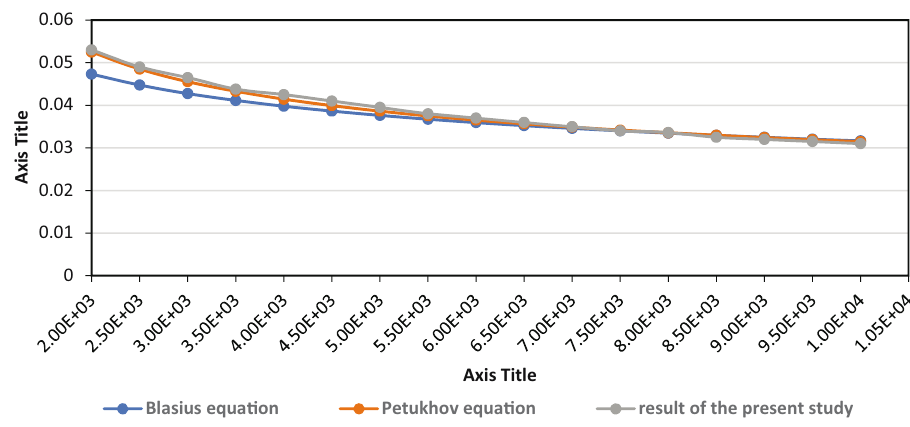
Figure 3: The comparison of friction factor for ba ffl e - free geometric model with experimental relations.